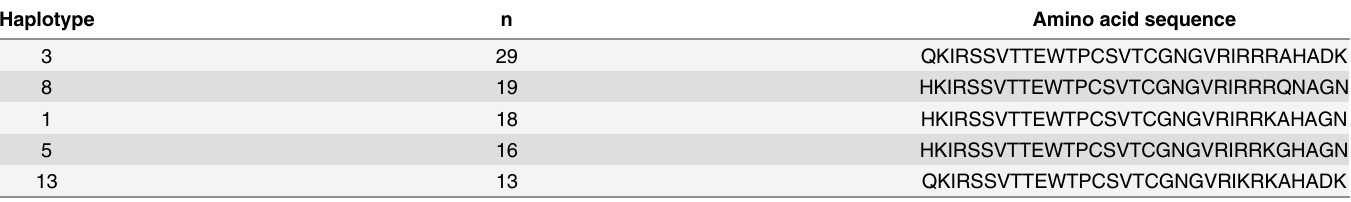
Table 3. Most abundant PkCSP Th2R/Th2R